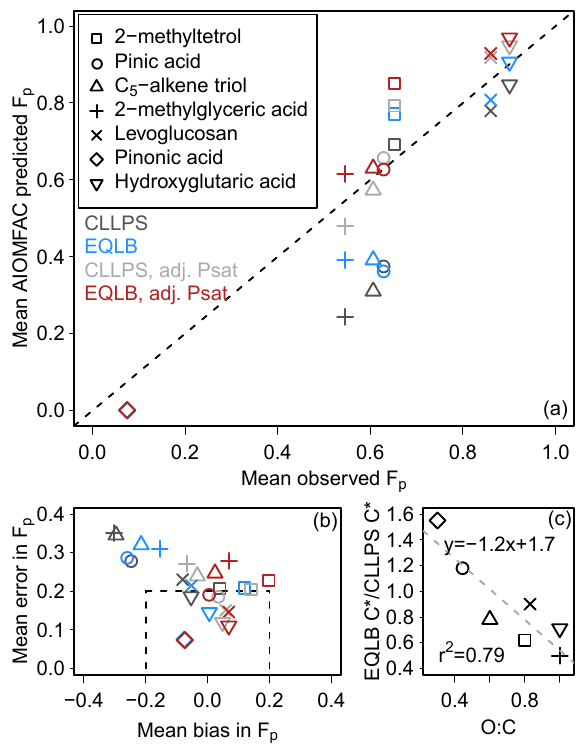
Figure 5. Observed and predicted equilibrium partitioning of or- ganic compounds in the presence of MARGA-measured PM 2 . 5 in- P n (M i − O i ) organics, expressed as F p (a) . In (b) , mean bias = 1 i = 1 n P n | M i − O i | , where M i is the model pre- and mean error = 1 i = 1 n diction and O i is the observation of F p . The ratio of mean satura- tion concentration under EQLB compared to CLLPS conditions (c) uses predictions from the adjusted vapor pressure calculations (Adj Psat). Modeled particulate 2-methyltetrols are 50% dimers except with Adj